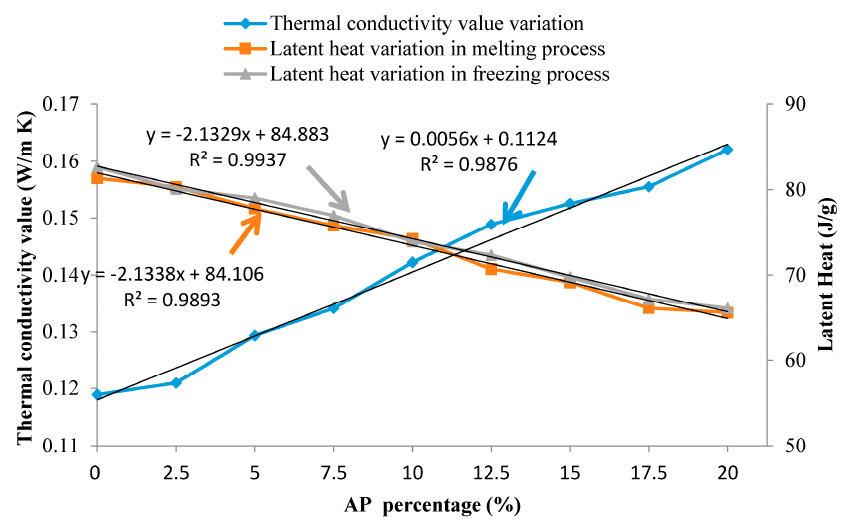
Figure 11. Variation comparison of thermal conductivity value and latent heat with different AP mass fraction for TD-LA/EP-AP. Table 6. Comparison of heat storage parameters of the novel composite PCM with that of some PCMs in another researches.